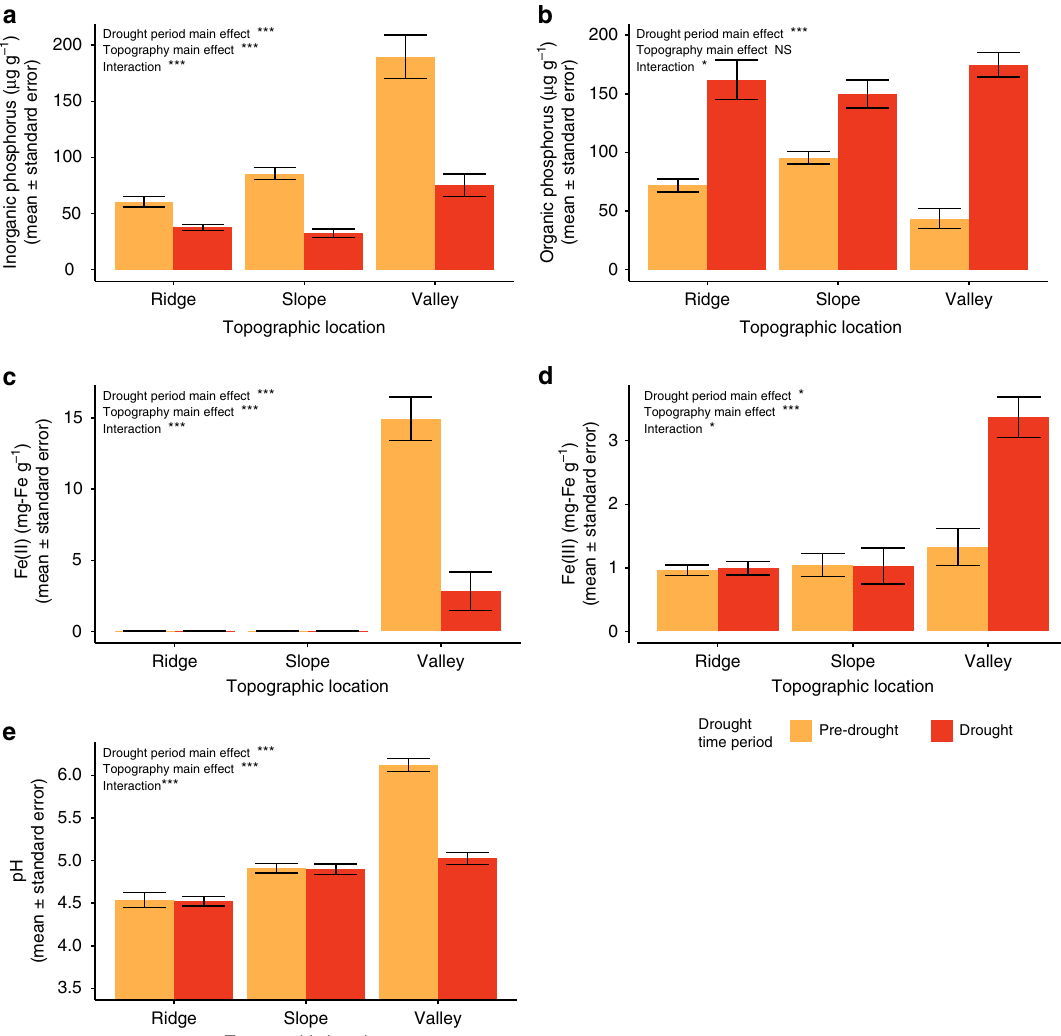
Fig. 4 Soil biogeochemical variables before and during drought. Panels show a inorganic P, b organic P, c Fe(II), d Fe(III), and e pH. Bars are the mean value; error bars represent ±1 s.e.m. Statistical results are reported from a two-way ANOVA in which drought period, topographic location, and their interaction were predictors of the given soil variable; effects are marked as *** when p -value <0.001, ** when p -value <0.01, * when p -value <0.05, and as NS when p - value ≥